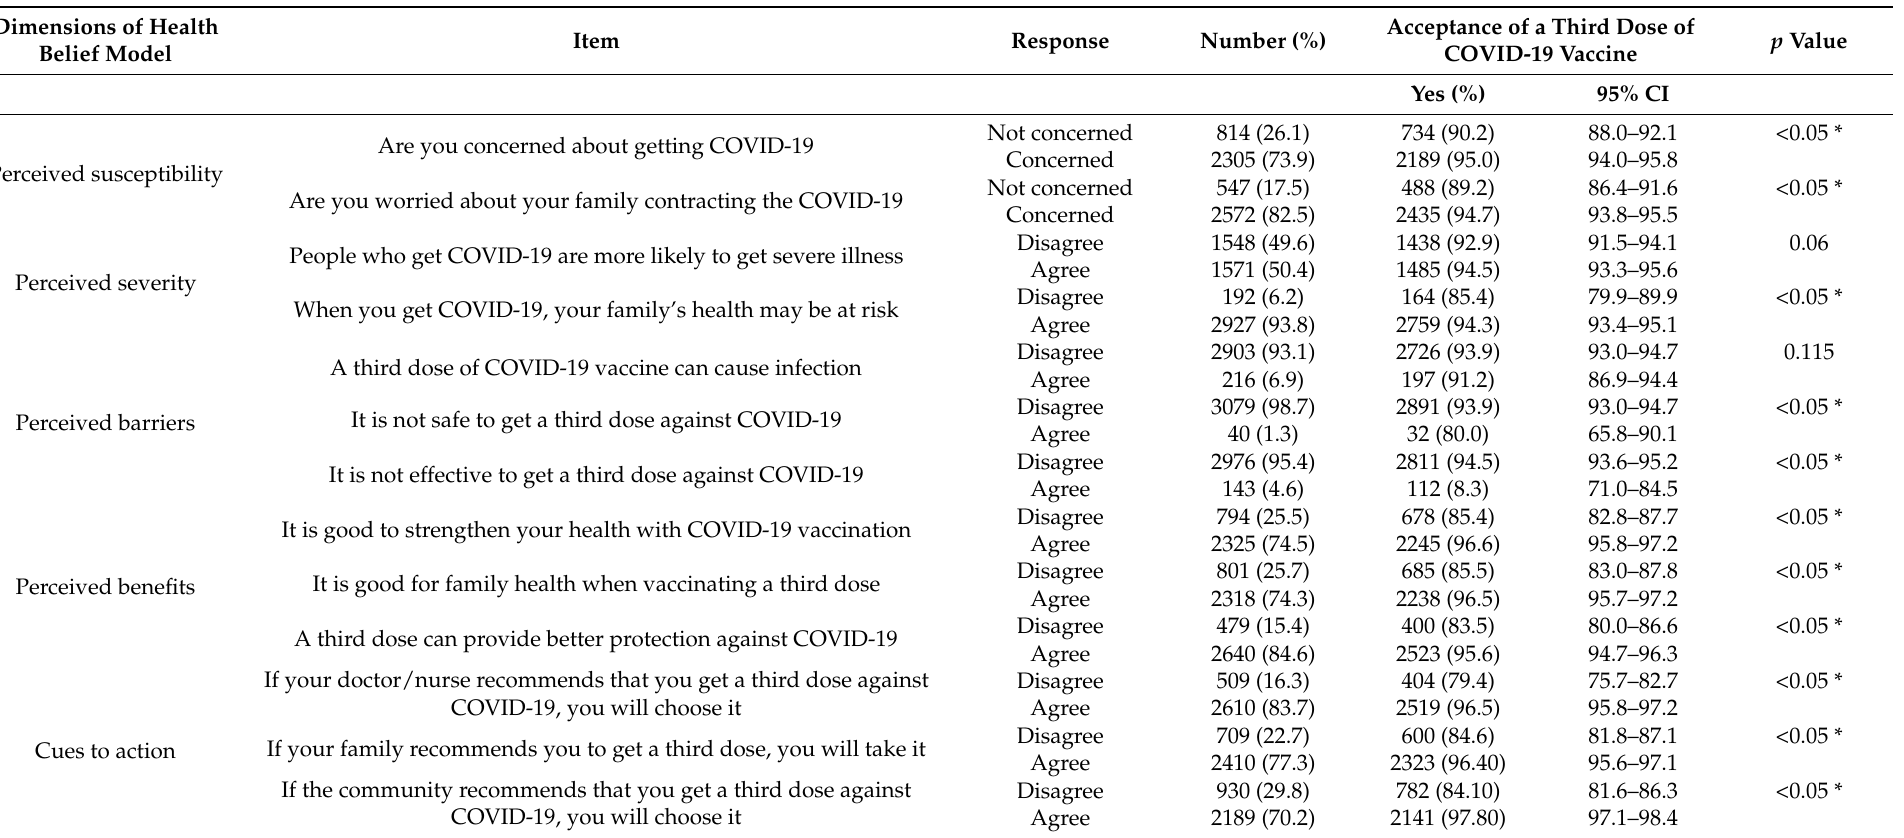
Table 2. Comparison of the acceptance of a third dose for COVID-19 vaccination based on the health belief model (n =